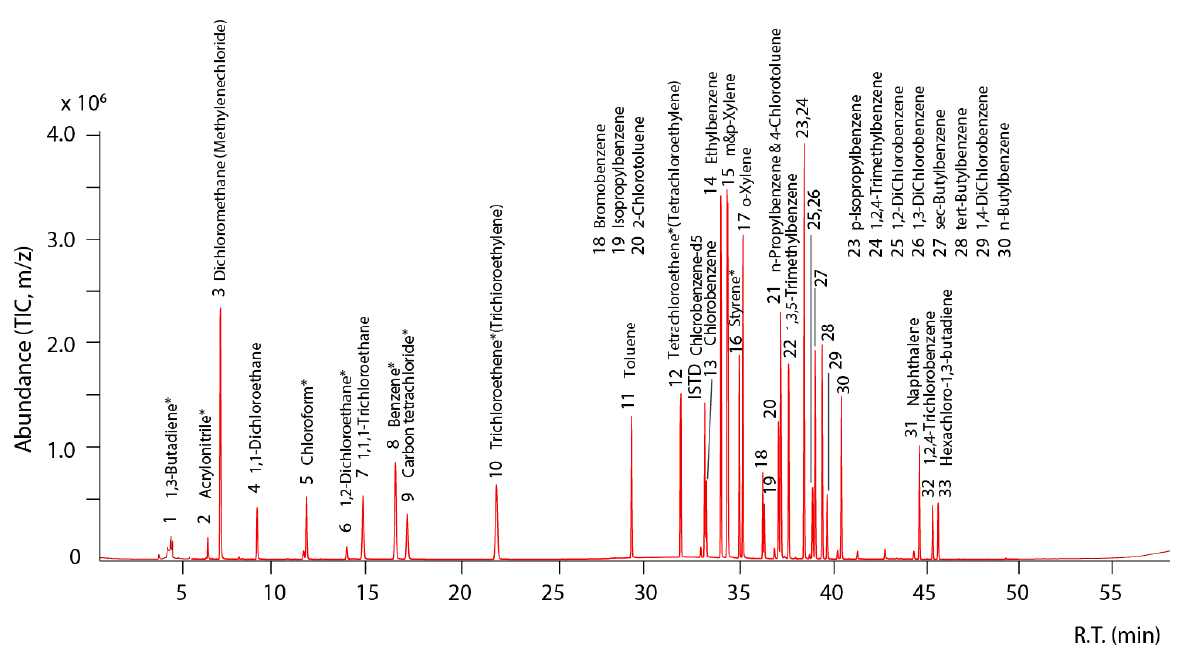
Figure 3. GC-MS chromatogram of the volatile organic compounds (VOCs) released by thermal desorption.